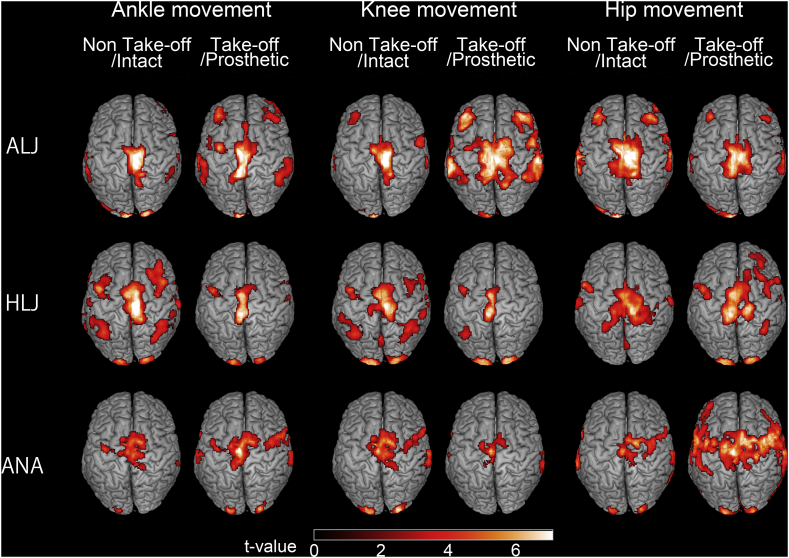
Activated regions during ankle, knee and hip movements in an elite long jumper with a below-knee amputation (ALJ), a representative healthy long jumper (HLJ: subject 7 in Table 1), and a representative non-athlete with a below-knee amputation (ANA: subject 2 in Table 1). Take-off/Prosthetic legs are displayed as right limb movements. Non-take-off/Intact legs are displayed as left limb movements. The threshold was set at a voxel level of p < .001 (uncorrected), and a cluster level of p < .05 (FWE).